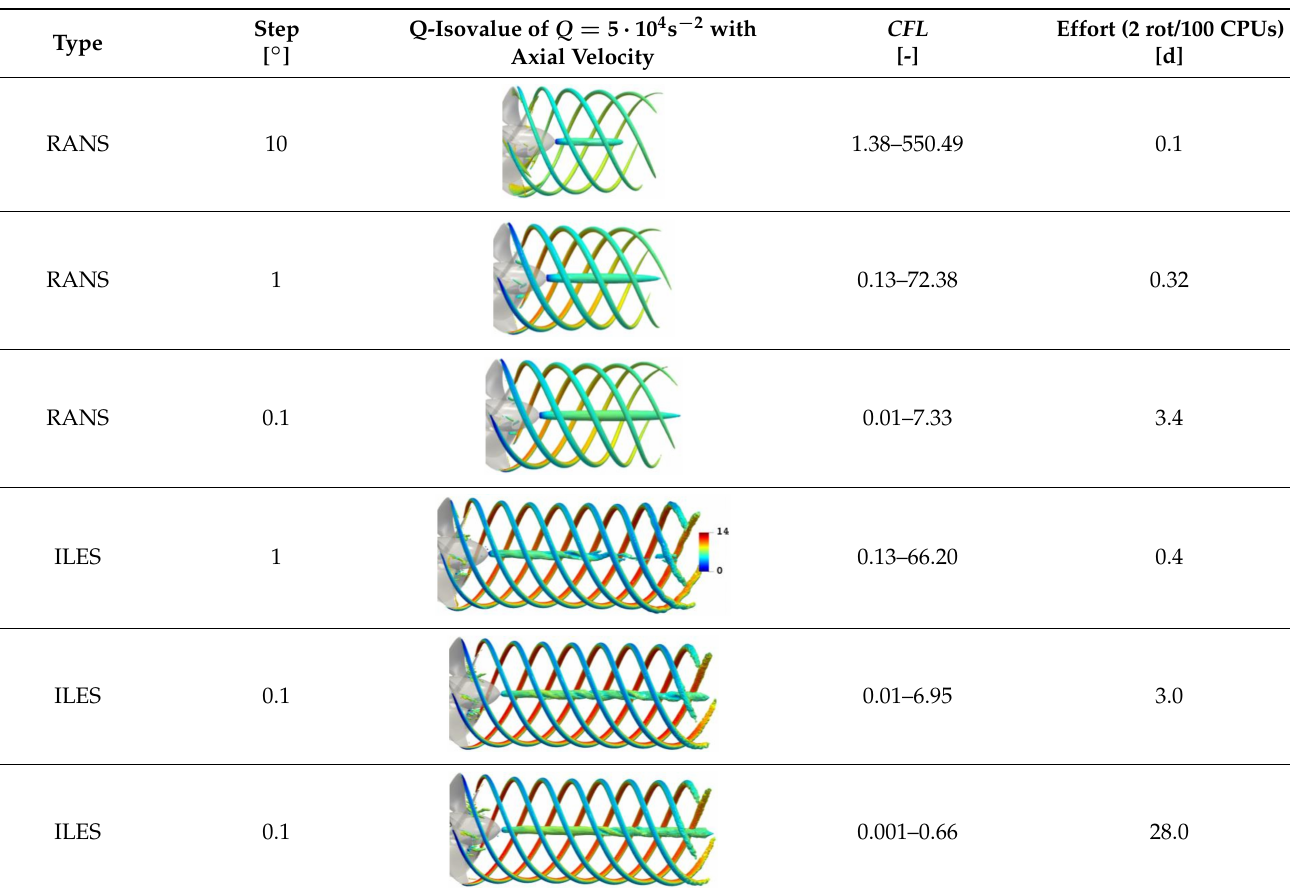
Table 3. PPTC’11. Effect of time step size on the propeller slipstream vorticity for an identical mesh without mesh refinement step at J = 1.019, partly based on